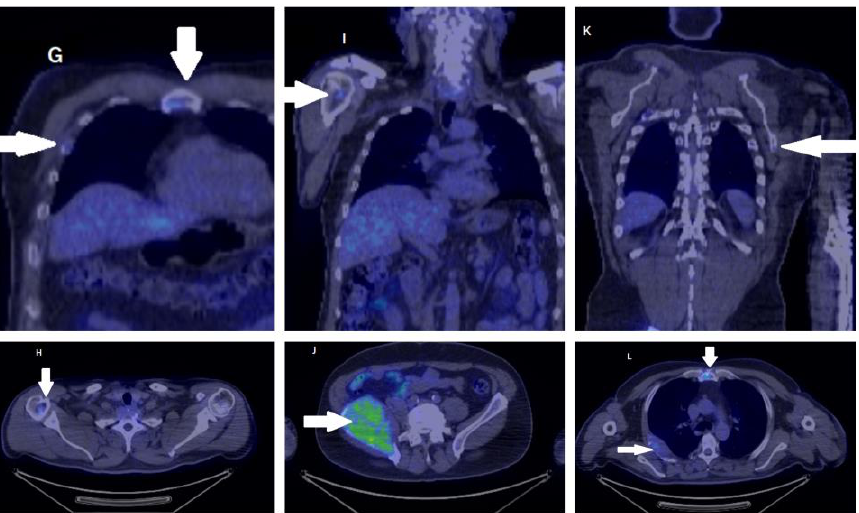
Figure 4. PET-CT showed an activated metabolism (arrow) of a mass in the right iliac wing of 10/7.5 cm that invaded the neighboring endo- and exopelvic structures. The mass showed an inhomogeneous uptake of FDG. Other similarly moderate FDG-capturing osteolytic lesions could be distinguished in the right posterior fourth costal arch (invasive and dimensional progression compared to the CT scan performed 1 week before), the right fourth anterior costal arch, the left sixth lateral costal arch, the sternal manubrium, the medial angle of the scapula on the left, the C7 (with a major risk of subsidence), the T7 and T9 vertebral bodies, the right lateral clavicular extremity, the right humeral head, the apex, the right temporal bone, right parietal bone, and the left sciatic tuberosity.